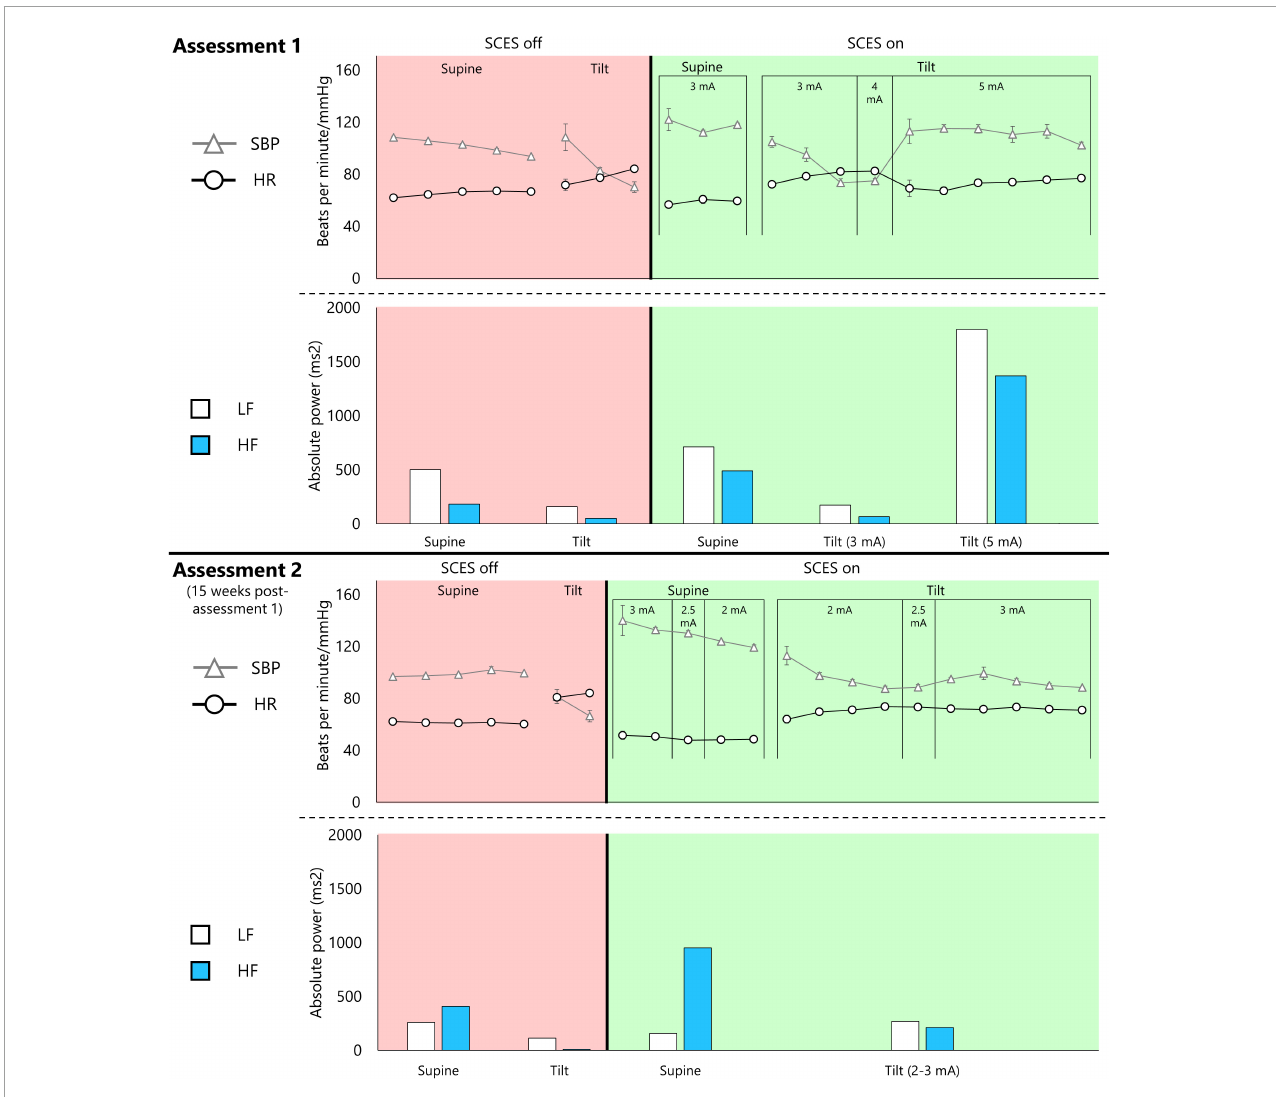
FIGURE5 Cardiovascular autonomic response to EAW enhancement SCES during a 45-degree head-up-tilt. Assessment 1 was captured 15 weeks before assessment 2. Both assessments followed the same protocol. The participant was initially in supine lying for 5 min followed by an attempt to perform a head-up tilt using a motorized tilting table for 10 min. The tilting maneuver was discontinued if systolic blood pressure (SBP) dropped by 40 mm Hg from resting baseline. This is followed by repeating the same protocol with SCES on after a 30-min washout period. The SCES was turned on 3–5 min in supine lying before performing the head-up tilt maneuver. A similar timeline was repeated in assessment 2. Triangles and circles represent 1-min averages of SBP and heart rate (HR), respectively. Low-frequency (LF) and high-frequency (HF) components of a heart rate variability analysis are presented for the entire corresponding supine or head-up tilt